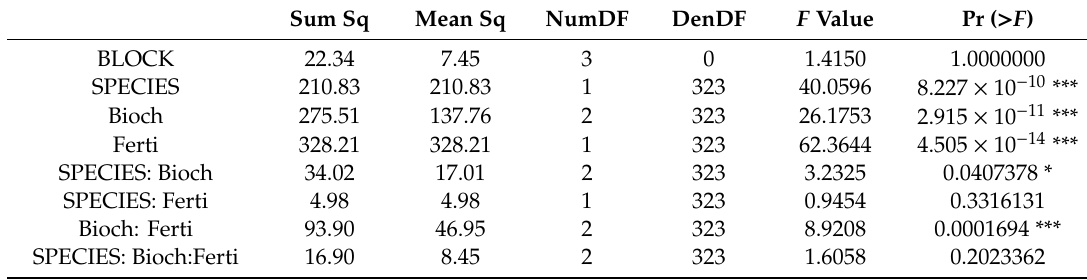
Table A8. End Plant Number of